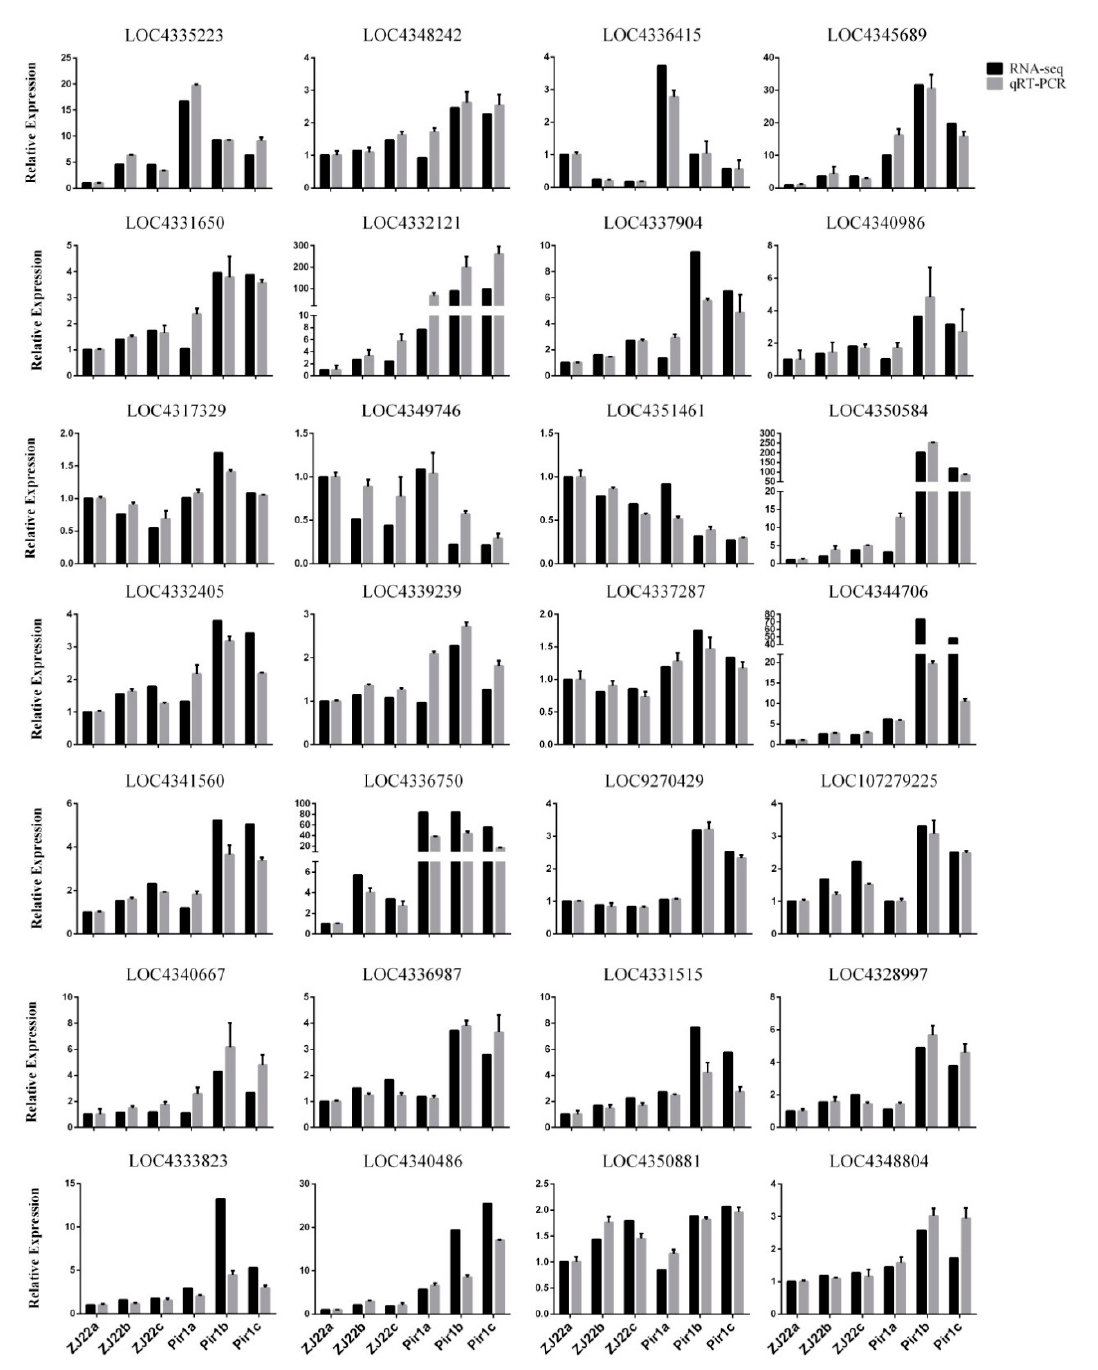
Figure 12. The expression profiles obtained by qRT-PCR and the results of RNA-Seq analysis showing that the two sets of data are well correlated. Results are the means ± standard error of three replications.